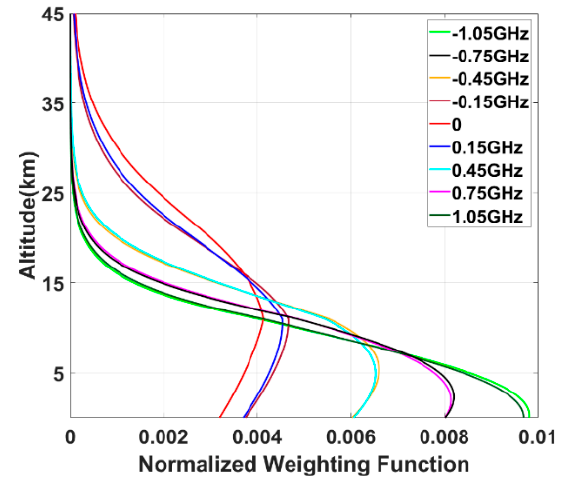
Figure 8. Results of weight functions changing with altitude at various on-line wave numbers. The red line indicates the CO 2 absorption center at 6361.250 cm − 1 , and the frequency shift is zero; the black line is at 6361.225 cm − 1 , and the frequency shift is − 0.75 GHz.